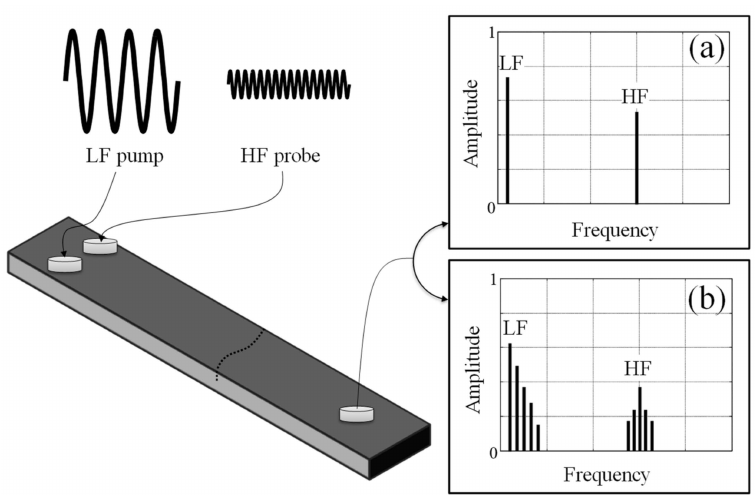
Figure 1. Schematic diagram illustrating the principle of the nonlinear vibro-acoustic modulation technique used for crack detection: ( a ) uncracked structure; ( b ) cracked